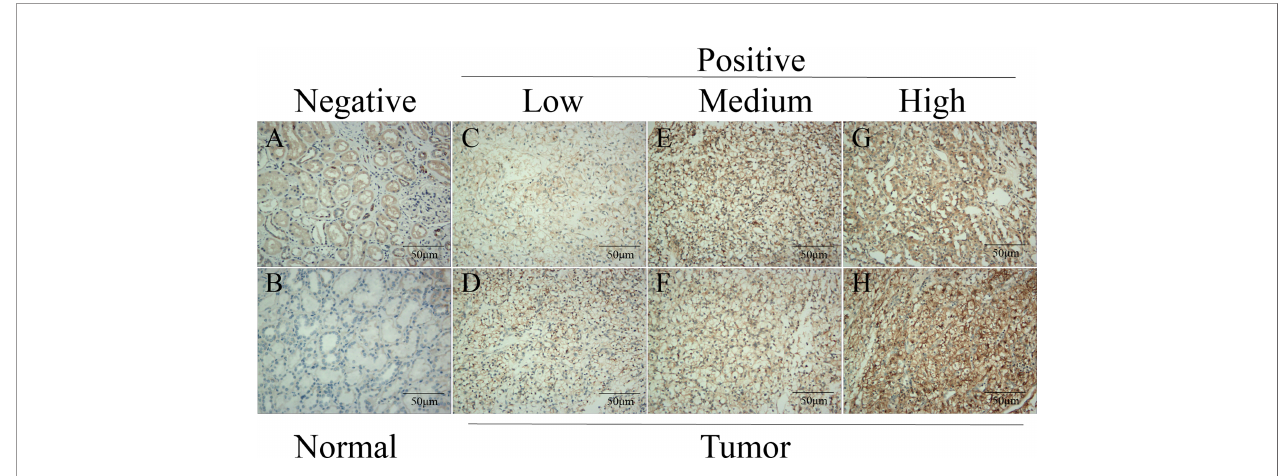
FIGURE 2 | Validation of the protein expression levels of ADAMTS14 by immunohistochemistry in ccRCC tissue specimens. (A, B) Negative expression of ADAMTS14 in adjacent normal tissue specimens of ccRCC patients. (C, D) Low expression of ADAMTS14 in ccRCC tissues. (E, F) Medium expression of ADAMTS14 in ccRCC tissues. (G, H) High expression of ADAMTS14 in ccRCC tissues; scale bar = 50 m